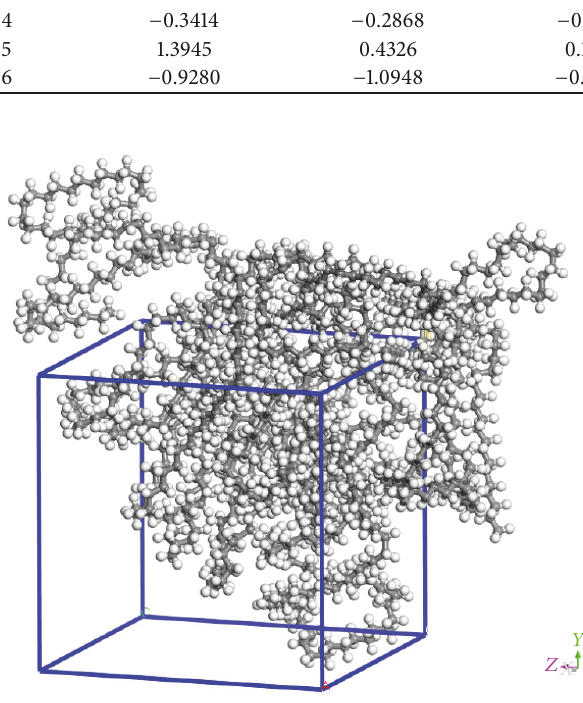
Figure 12: Ultimately saturated phenol model.